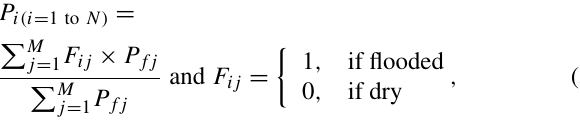
Table 3. Flooded areas of different land classes corresponding to the three worst-case